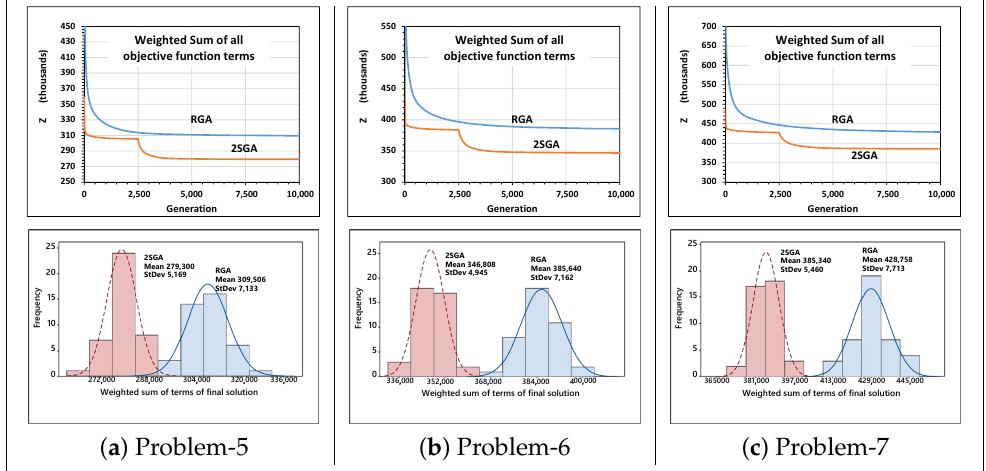
Figure 13. The convergence of 2SGA and RGA in solving Problems 4, 5, and 6. (Each convergence graph is an average of 40 trials. The histograms are for the final values of the objective function in 40